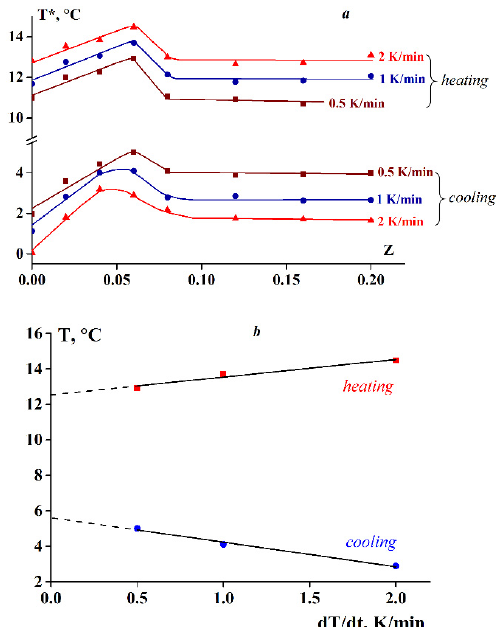
Figure 2. Transition temperature T* dependency on the SA-gelatin mass ratio Z for cooling and heating at temperature ramp rates shown on the curves ( a ) and transition temperature T* dependency on cooling and heating rates for the Z = 0.06 SA-gelatin mixture ( b ). Analysis of the experimental data indicated that the transition temperature is of a kinetic nature, as it depends on the composition of the SA-gelatin mixtures and the tem- perature scanning rate (Figure 2a). As shown in Figure 2a, the sol-gel transition tempera- ture reaches a maximum at a certain ratio when Z = 0.06. As the temperature ramp rate increases, the transition temperature decreases in the cooling mode and, in contrast, in- creases in the heating mode. The rate dependence of the maximum T* values is shown in Figure 2b. Extrapolation to the static condition dT/dt = 0 (where t is time) does not exclude the difference in T* values obtained for heating and cooling. Of note here is the tendency toward a decrease in the difference between them. The kinetic nature of the sol-gel transition is well illustrated by the data obtained at various frequencies. The original experimental data used to determine T* are included in the Supplementary File (Figure S2). Figures 3 and 4 indicate that for systems with low SA content (Z < Z* = 0.06), the transition temperature T* is weakly dependent on the fre- quency. In contrast, at higher Z values, the role of frequency becomes more pronounced.